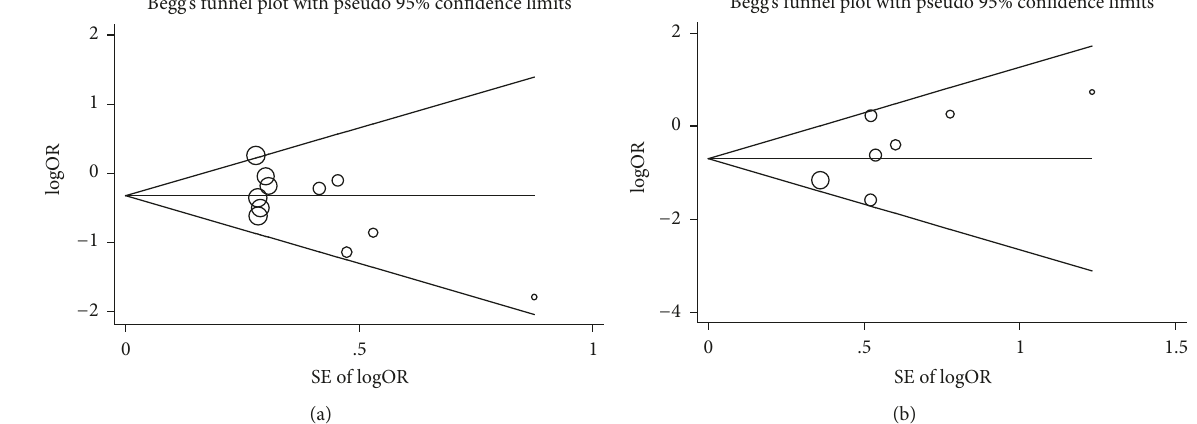
Figure 7: Begg’s funnel plot for publication bias test. (a) The incidence of PMI and (b) the incidence of